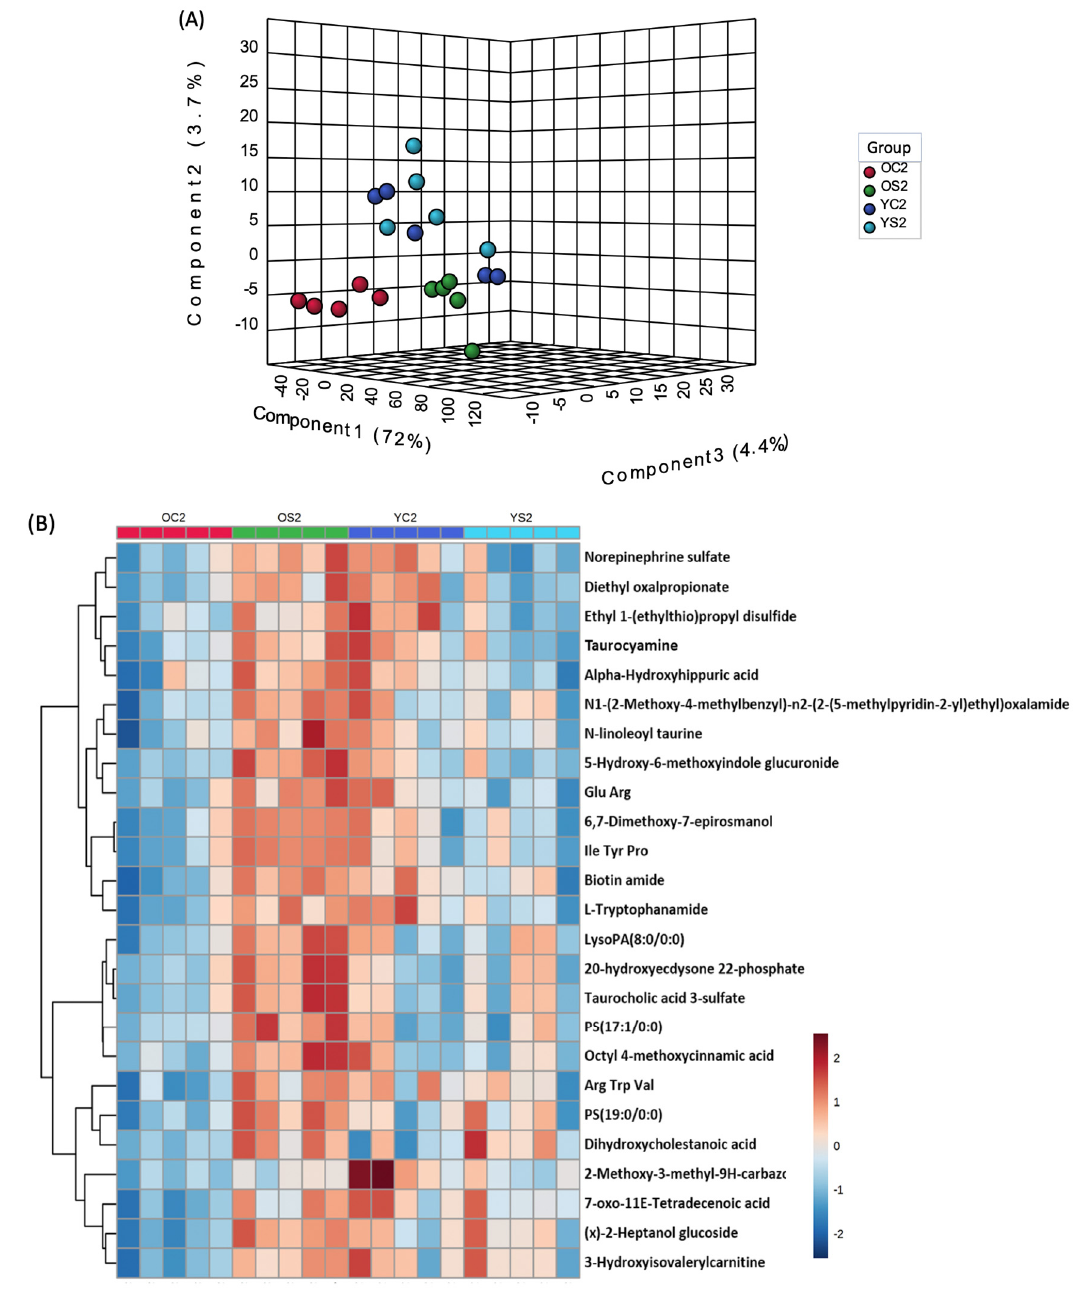
Figure 6. ( A ) A 3D partial least square discriminant analysis (PLS-DA) plot showing group separation based on metabolic profiles. X-axis shows inter-group separation, while Y-axis illustrates intra-group separation. ( B ) Heatmap showing normalized abundance of metabolites across the four study groups (OC2, OS2 , YC2, YS2).